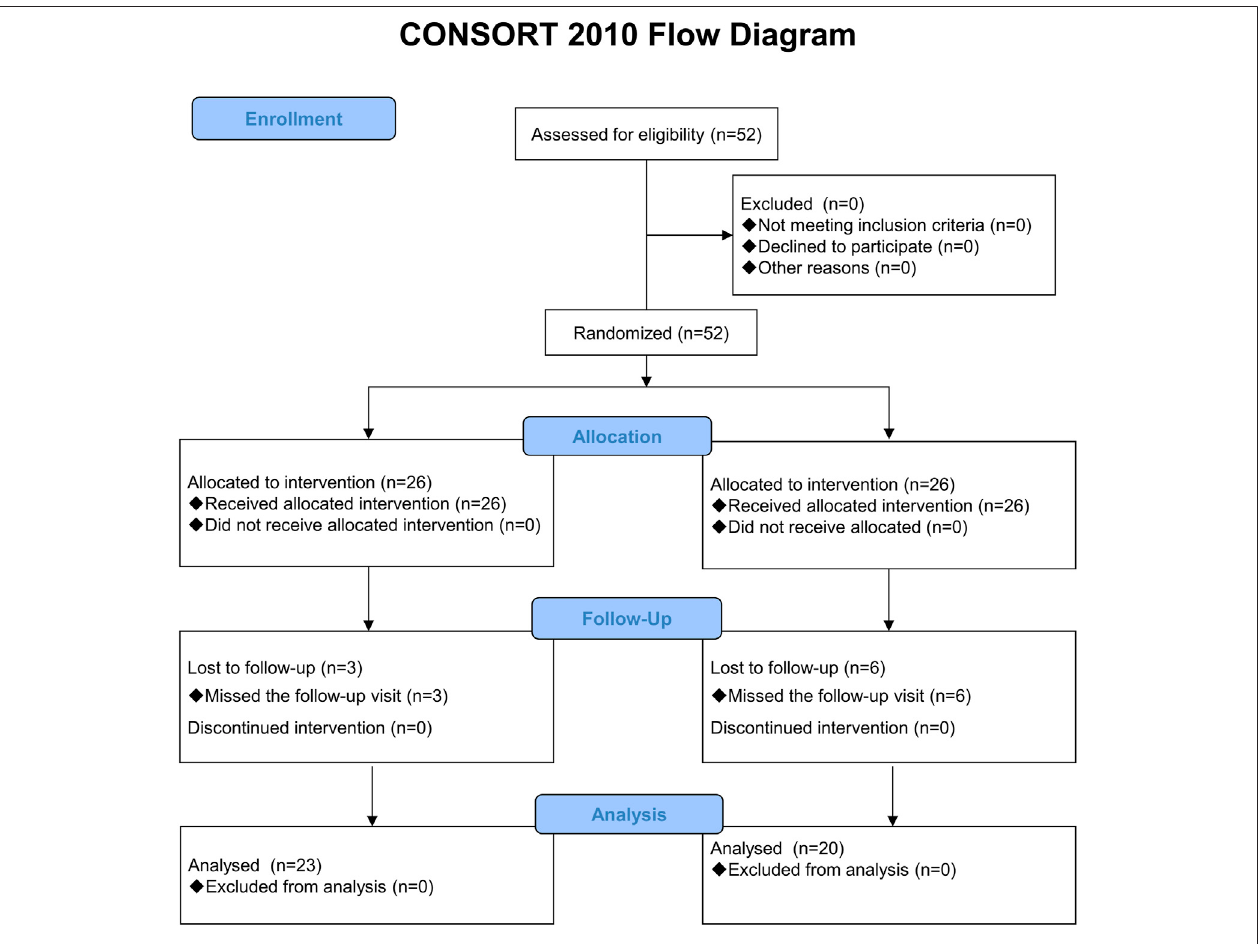
FIGURE 1 | Study fl ow chart.